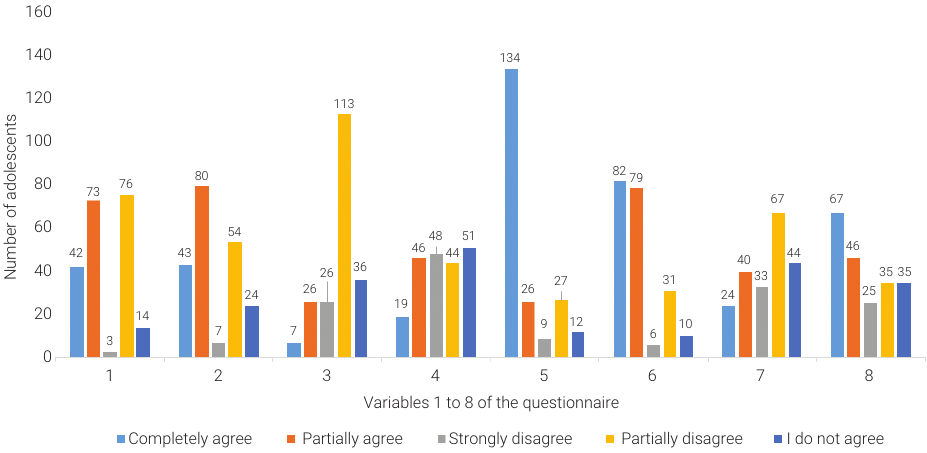
Figure 5. Graphical representation of number of adolescents of G2 who answered the 8 variables of the questionnaire (1 to 8) according to the Likert scale for